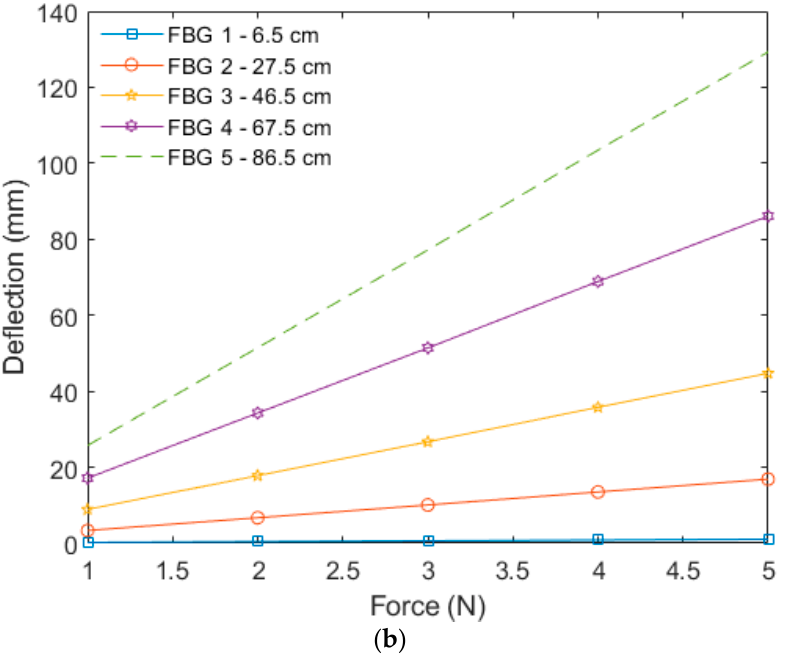
Figure 3. Numerical results of the displacement as a function of the applied force in the free end of the ( a ) Wooden beam; and ( b ) Nylon 6.0 beam.